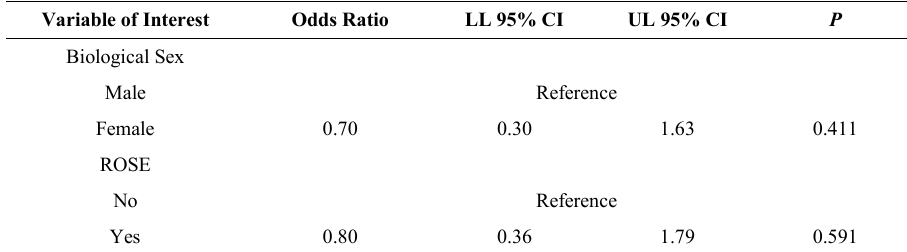
Table 3. Multivariable Mixed Effects Binary Logistic Regression for Prediction of Adequacy